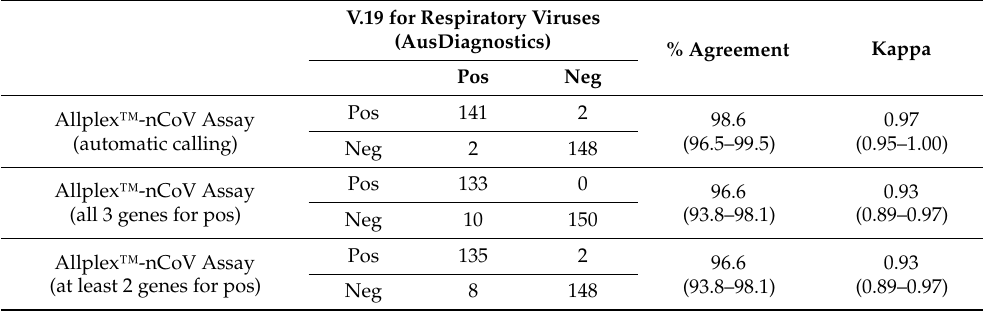
Table 3. Comparison between the Respiratory Viruses 16-Well Assay V.19 and the Allplex™-nCoV Assay.